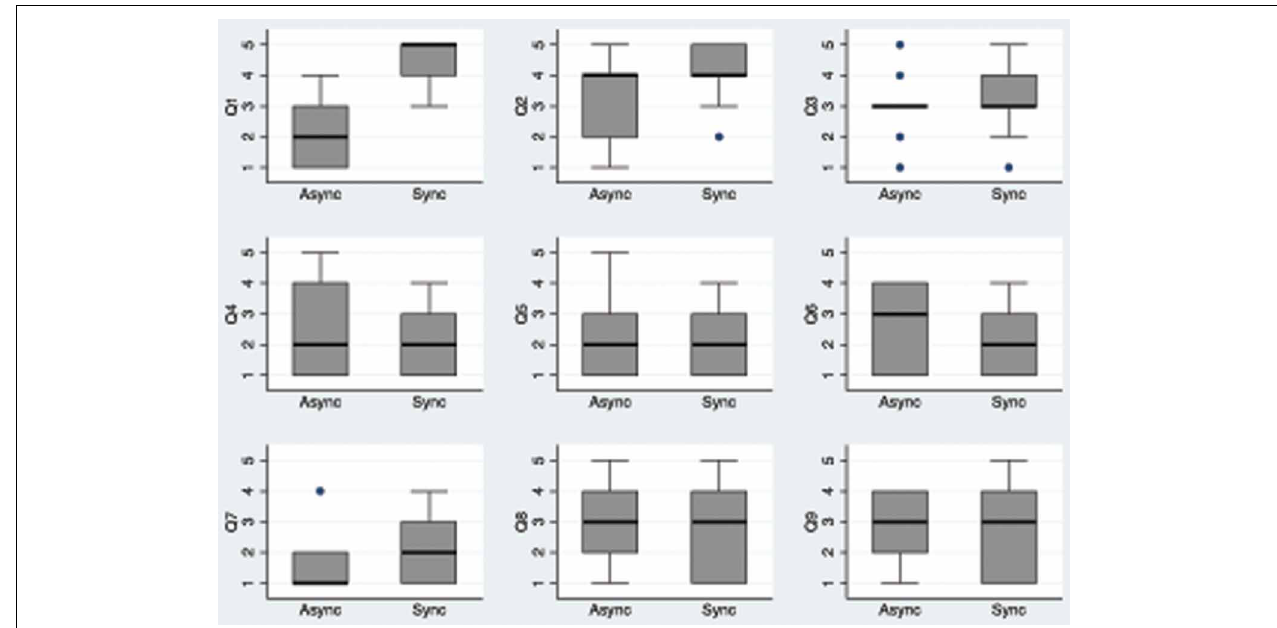
FIGURE 2 | Box plots of the questionnaire data by condition. The thick horizontal lines are the medians, the boxes are the interquartile (IQR) ranges, the whiskers extend to the highest or lowest data point within 1.5 ∗ IQR. Values outside of this range are marked by single points.